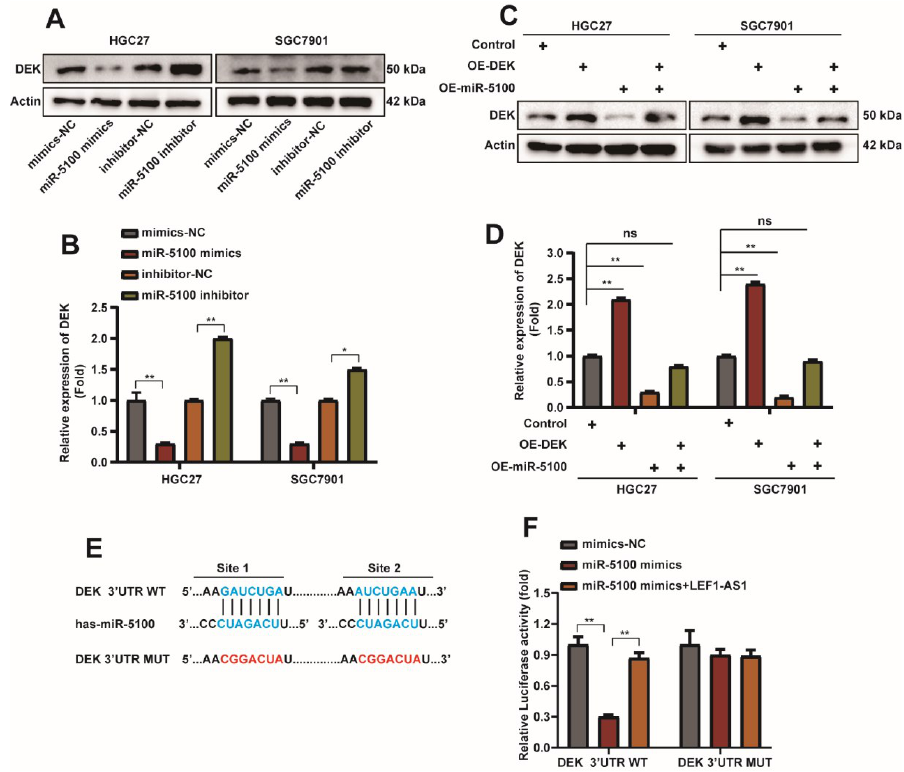
Figure 7. miR-5100 can directly bound to the 3′ UTR of DEK and regulate DEK expression. ( A , B ) Western Blot detection of DEK expression when miR-5100 mimics/mimics-NC/miR-5100 inhibitor/inhibitor-NC was transfected into HGC27 and SGC7901 cells for 36 h, and the experimental results were quantified with Actin Normalized ( n = 3, *: p < 0.05, **: p < 0.01). ( C , D ) Western blot detection of DEK protein when miR-5100 mimics + OE-NC/OE-DEK + mimics-NC/5100 mim- ics + OE-DEK were transfected into HGC27 and SGC7901 cells, co-transfected with mimics-NC and OE-NC as controls. Quantitative analysis of experimental results was normalized with Actin ( n = 3, **: p < 0.01). ( E ) Construction of WTDEK- Schematic representation of the 3 (cid:48) UTR-WT and DEK-3 (cid:48) UTR-Mut luciferase reporter plasmids. ( F ) DEK 3 (cid:48) UTR-WT/Mut and mimics-NC/miR-5100 mimics/miR-5100 mimics + LEF1-AS1 were co-transfected, and the luciferase reporter assay verified the targeting between miR-5100 and DEK effect ( n = 3, **: p <